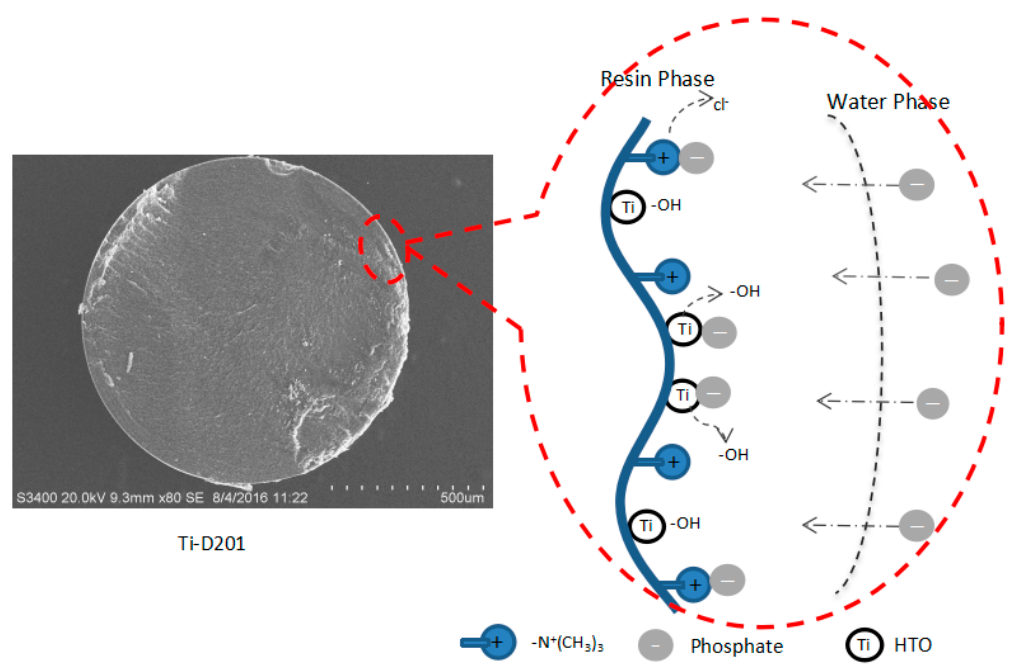
Figure 10. Simulation of HTO -D201 structure and adsorption principle.